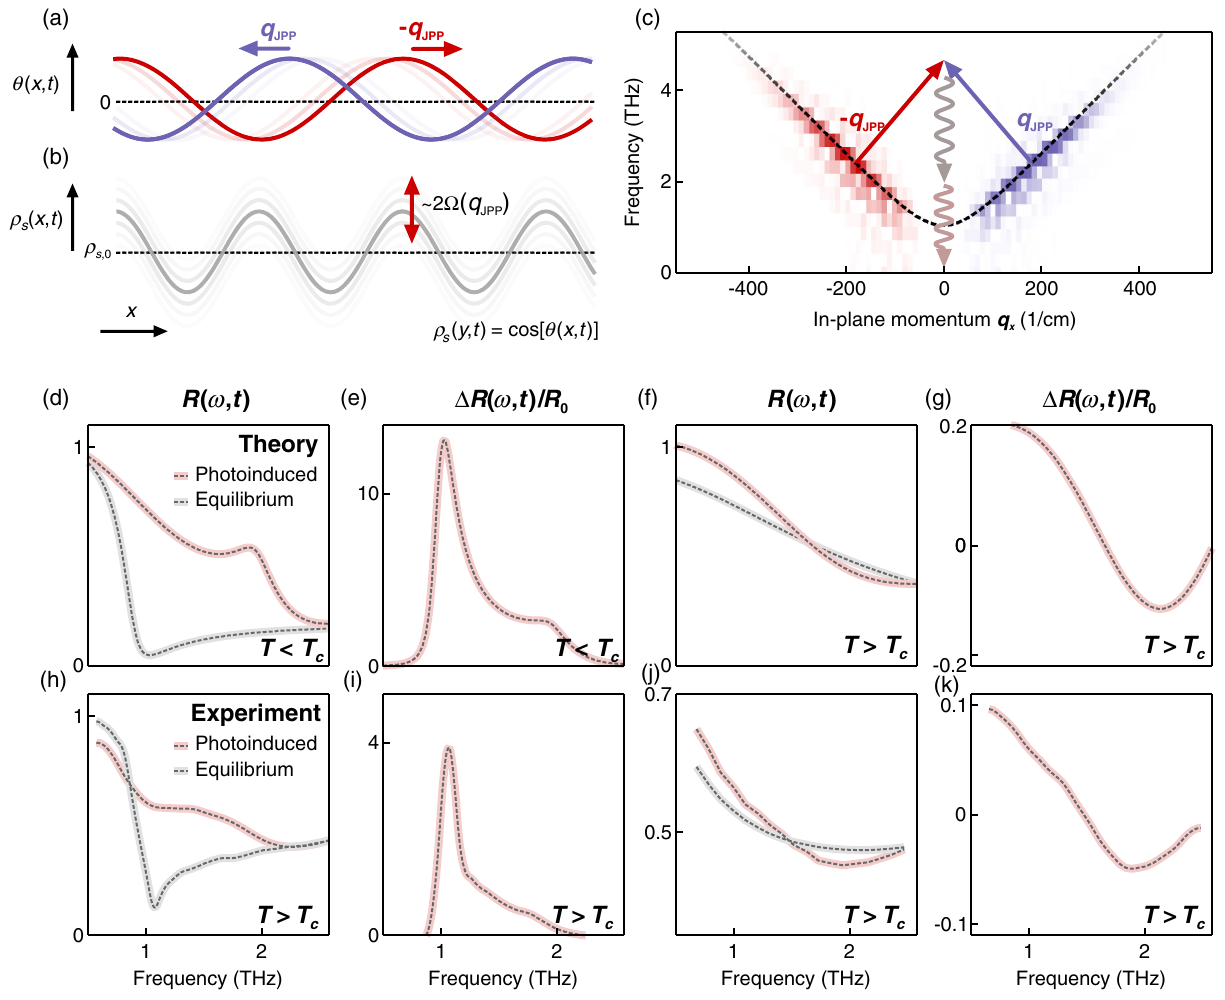
FIG. 6. (a) Two counterpropagating JPPs with in-plane momentum q periodically modulate the superconducting order parameter JPP θ ð x; t Þ along the x axis. (b) Resulting spatial and temporal (shaded gray) modulation of the superfluid density ρ x; t Þ around its s ð equilibrium value ρ . The zero-momentum temporal modulation proceeds at twice the Josephson plasma frequency 2 Ω ð q . s; 0 JPP Þ (c) Frequency-momentum diagram of the parametric amplification that drives the terahertz emission. The two counterpropagating JPPs 0 THz photons, each of frequency Ω ð q (red and blue shaded regions) add in energy and momentum to emit two q . (d),(e) x ¼ JPP Þ Calculated photoinduced (red) and equilibrium (gray) terahertz reflectivity below T and the normalized reflectivity changes c Δ R ð ω ; t Þ =R Ω ð q and overall 0 , respectively. The finite-momentum JPP induces a second plasma edge at a frequency close to JPP Þ enhancement of the reflectivity above the equilibrium plasma edge. (f),(g) Calculated photoinduced (red) and equilibrium (gray) terahertz reflectivity above T and the normalized reflectivity changes Δ R ð ω ; t Þ =R 0 , respectively. Excitation of the apical oxygen c vibration leads to the appearance of a plasma edge at a frequency close to Ω ð q , which is clearly visible in the normalized reflectivity JPP Þ changes Δ R ð ω ; t Þ =R 0 . Panels (h) – (k) show the same features, observed experimentally in time-resolved terahertz reflectivity measurements after resonant excitation of apical oxygen oscillations (Ref.